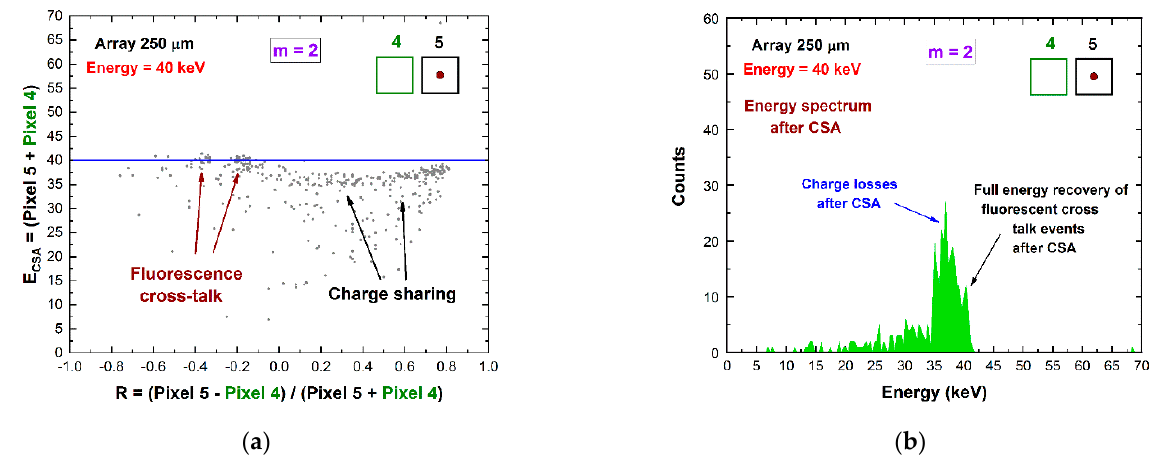
Figure 7. Experimental results after CSA for m = 2 coincidence events between adjacent pixels. ( a ) The 2D scatter plot of the energy E CSA after CSA versus the charge-sharing ratio R . ( b ) The energy spectrum after CSA.